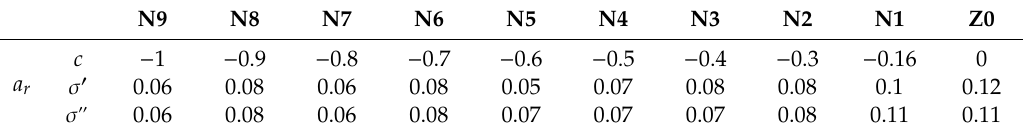
Table 5. The learning parameters of the expected